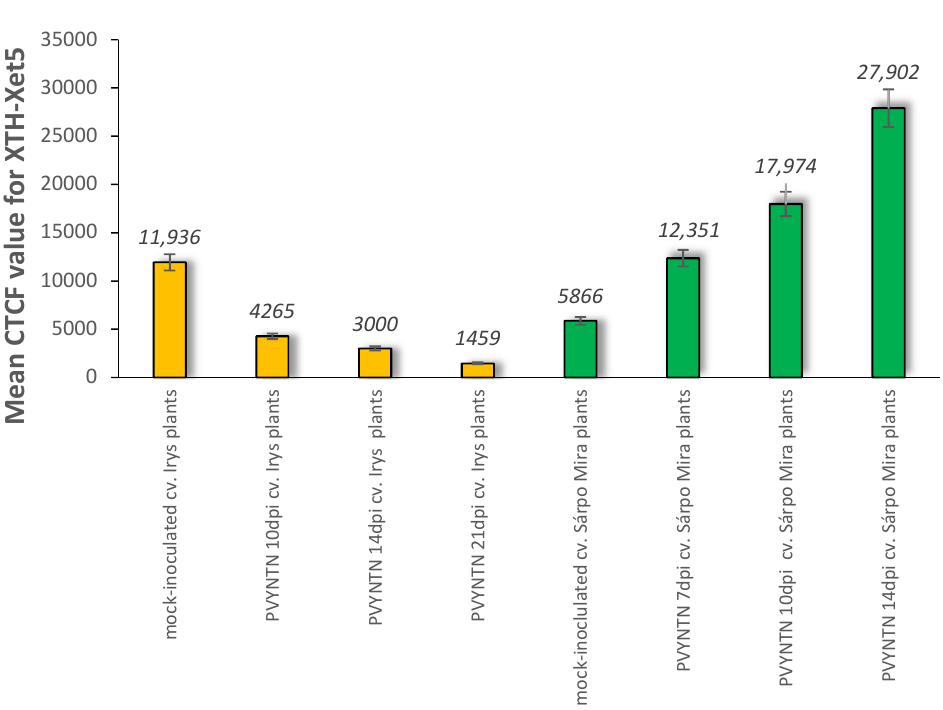
Figure 8. The assessment of the quantitative fluorescence signal of XTH/Xet5 by using the corrected total cell fluorescence method (CTCF) in combination with ANOVA statistical analyses. Yellow bars indicate mock-inoculated and also PVY inoculated cv. Irys (susceptible) potato plants at 10, 14 and 21 days post-inoculation. Green bars indicate mock-inoculated and also PVY-inoculated Sárpo Mira (resistant) potato plants at 7, 10 and 14 days post-inoculation. Mean values CTCFC were evaluated at the p < 0.05 level of significance using post hoc Tukey HSD test.